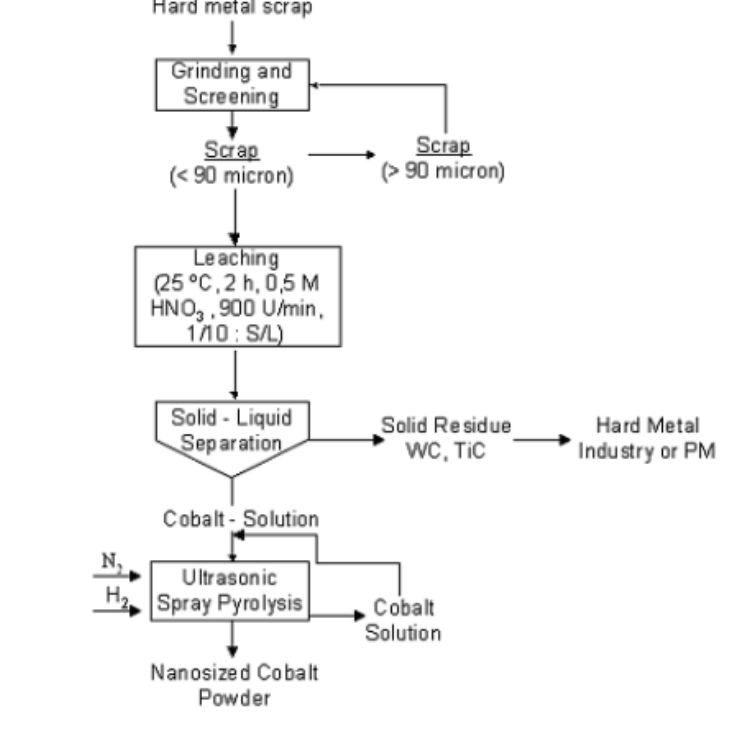
Figure 4 – Recovery of cobalt from cemented tungsten carbide Рис . 4 – Извлечение кобальта из цементированного карбида вольфрама Слика 4 – Издвајање кобалта из цементираног волфрам